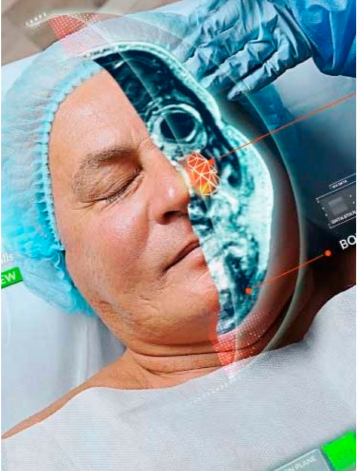
Figure 2. Diagnostic imaging can be overlaid on the patient prior to and during surgery. Many features can be added to the virtual MR world to allow the operator to access information in many domains at many levels of detail with a simple hand